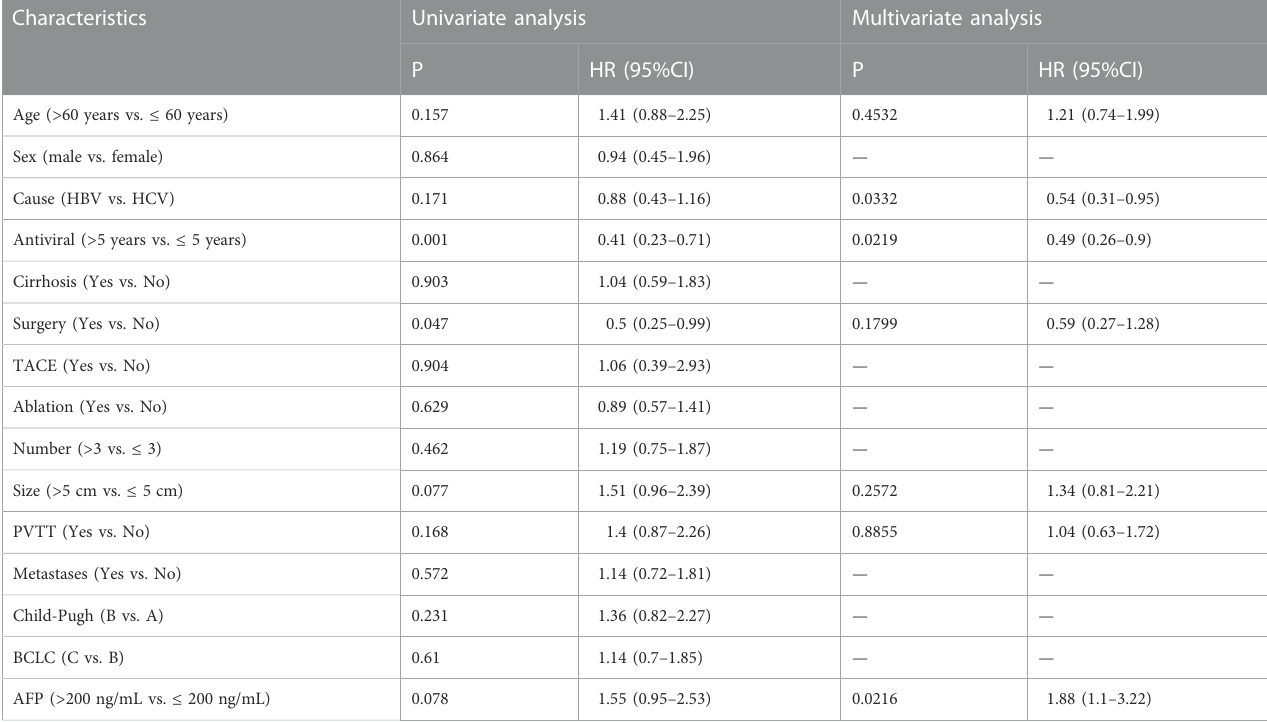
TABLE 2 Cox proportional hazards model of prognostic factors for PFS.